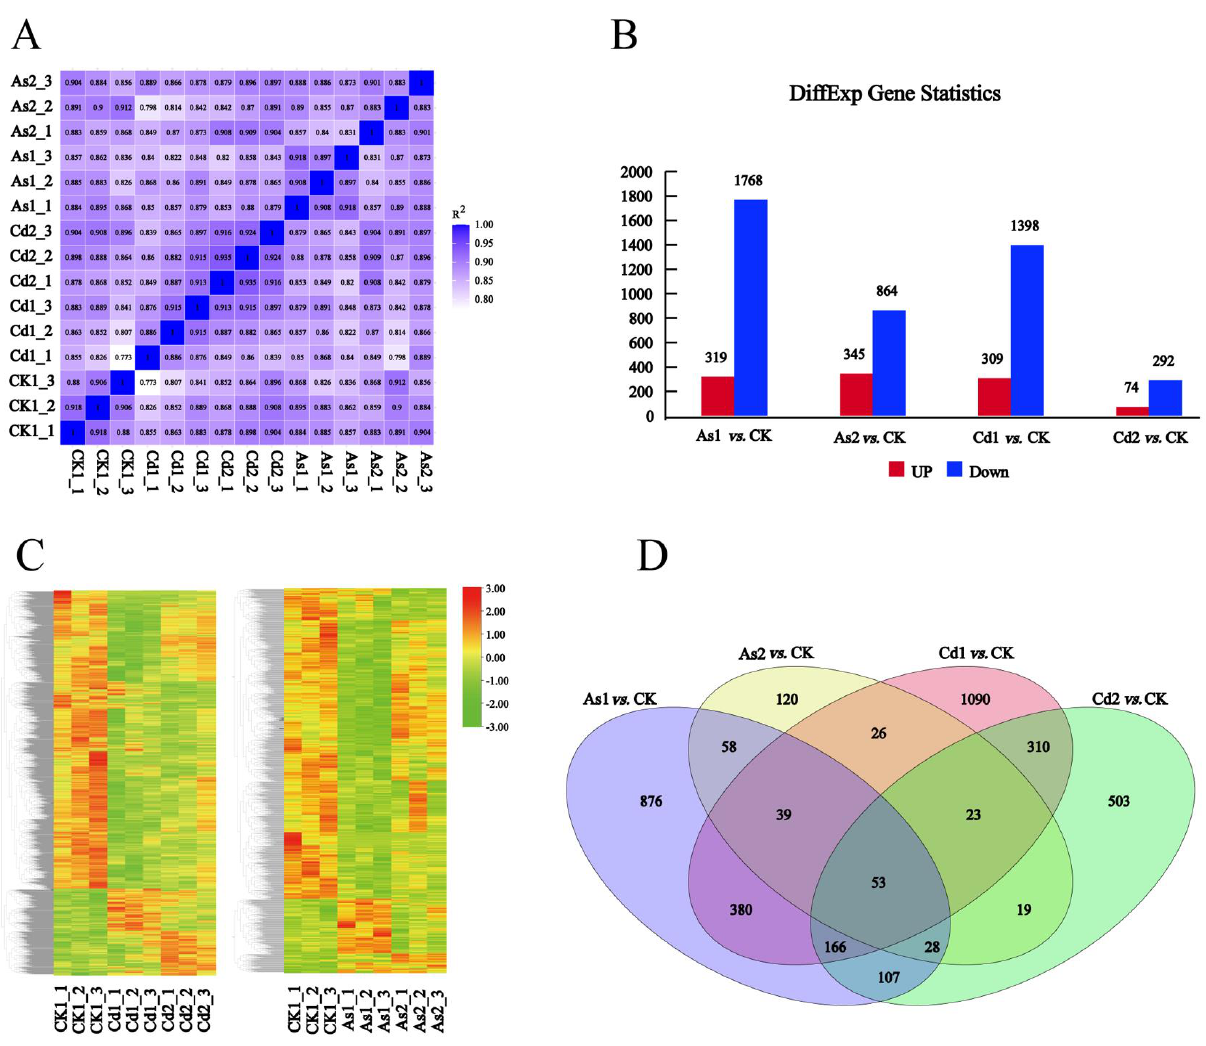
Figure 2. RNA-seq data analysis. ( A ) The correlation heat map of samples. The left gradient barcode color indicates the minimum value (0) in lavender and the maximum (1) in light blue. A value close to 1 indicates a high positive correlation, while a value close to 0 means no correlation. The heat map was drawn with DEseq (v3.5.1); ( B ) The number of up- or down-regulated DEGs in different pairwise comparisons. Blue and red columns represent the down- and up-regulated DEGs, respectively; ( C ) The expression patterns of DEGs between Cd-treated tea roots and the control group (right) and between As-treated tea roots and the control group; ( D ) Venn diagram of the DEGs among different pairwise comparisons. CK, control group; Cd1 and Cd2 indicate the tea roots treated with Cd for 10 and 15 days, respectively; As1 and As2 indicate the tea roots treated with As for 10 and 15 days,